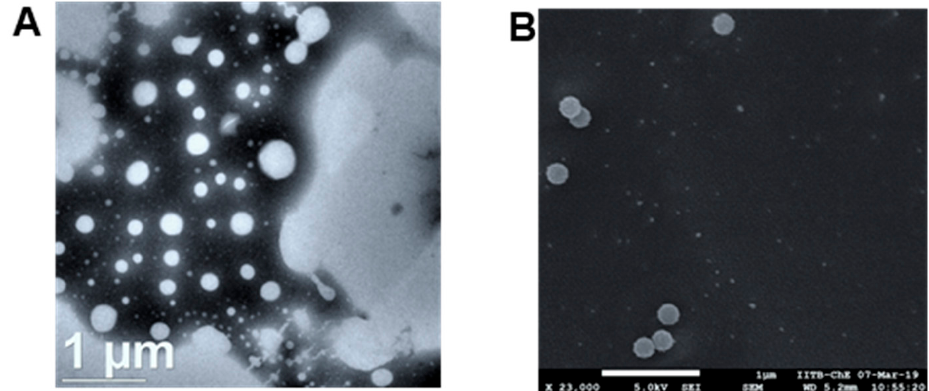
Figure 3. Electron microscopy images of chrysin-loaded, nanoemulsifying preconcentrate after dilution with water. ( A ) TEM image and ( B ) SEM image.